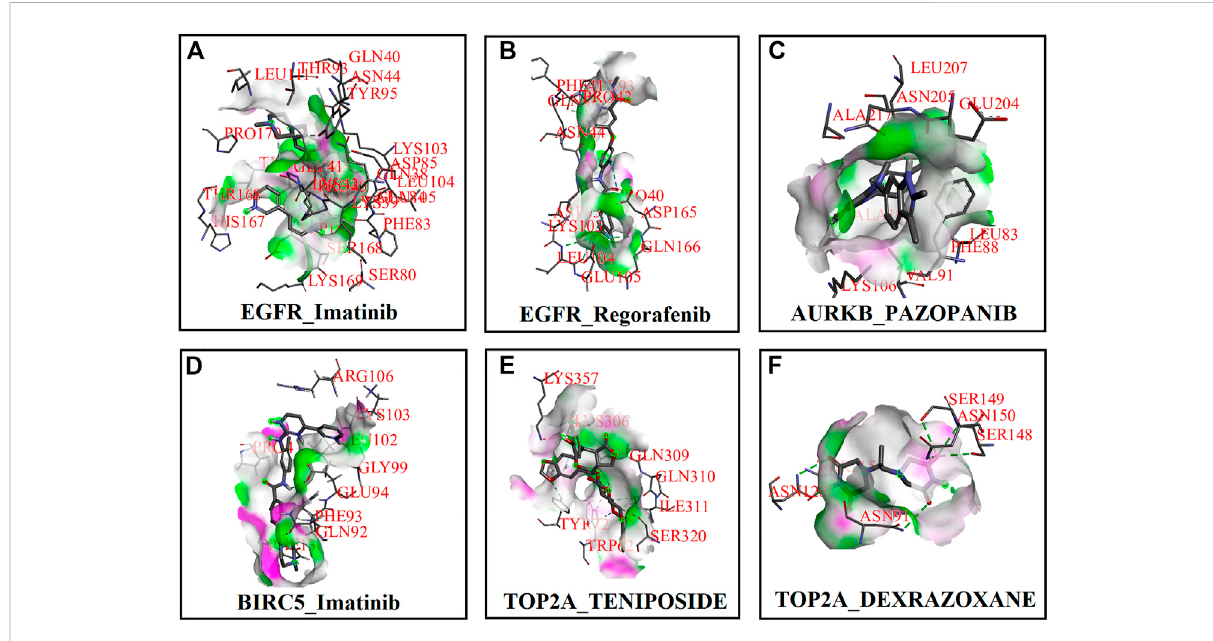
FIGURE 8 Three-dimensional (3D) structures between receptor proteins and candidate drugs and highlighting active site. (A) EGFR – imatinib, (B) EGFR – regorafenib, (C) AURKB – pazopanib, (D) BIRC5 – imatinib, (E) TOP2A – teniposide, and (F) TOP2A – dexrazoxane.